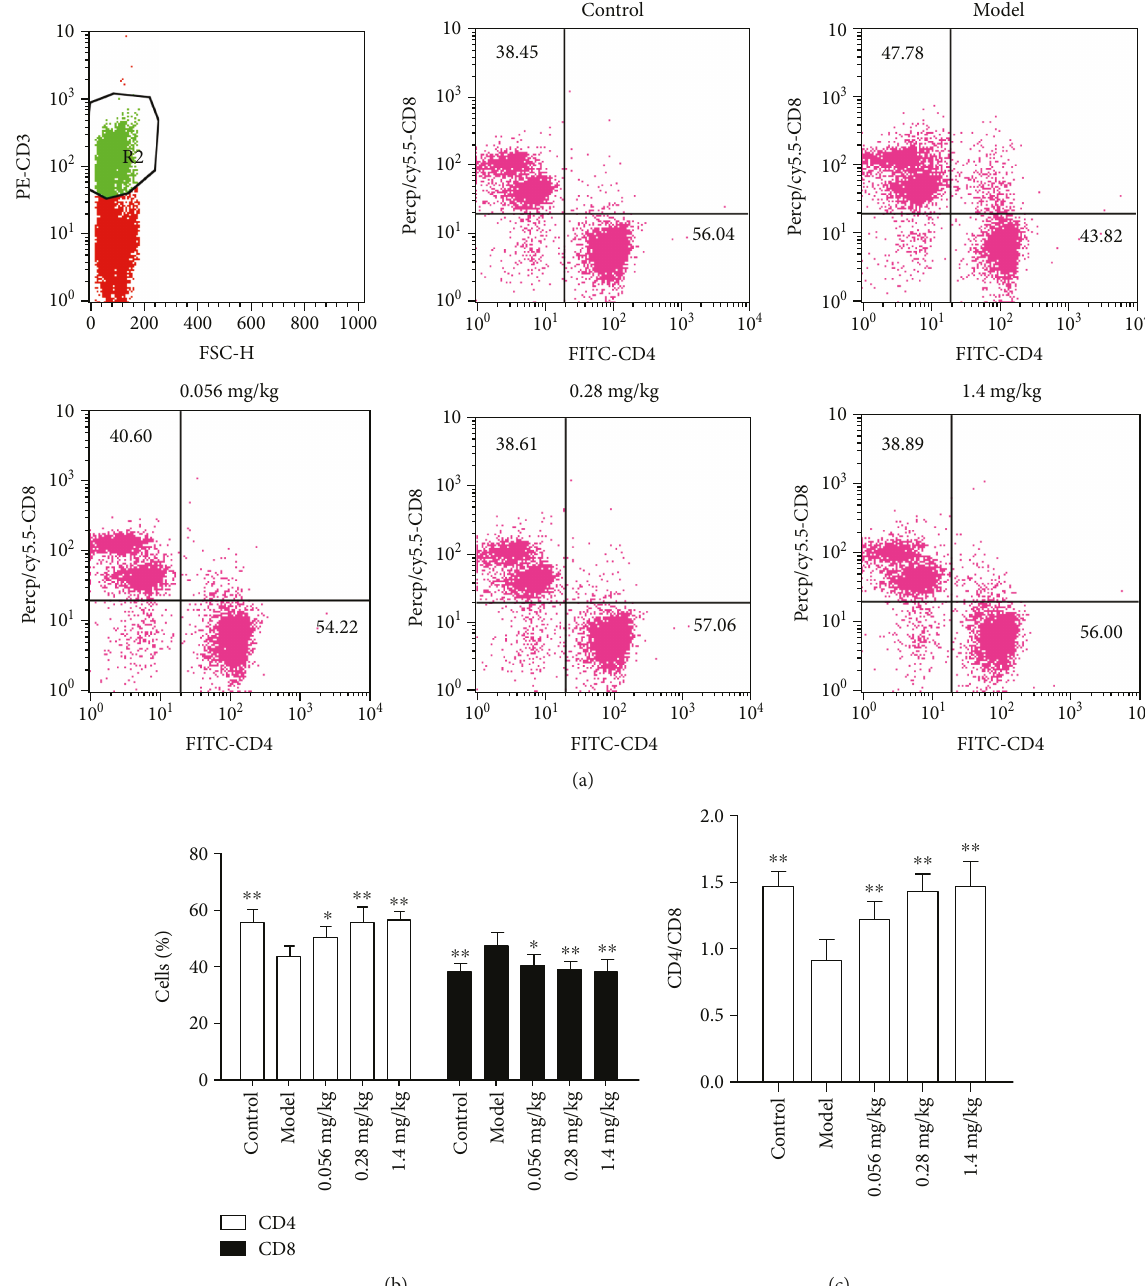
Figure 5: Koumine reduces the number of total leukocytes and CD4 + T cells in fi ltrated in the liver. The livers were isolated from model and koumine-treated rats. (a) Cells were analyzed for expression of CD4, CD8, and CD3 by fl ow cytometry. (b) The percentages of cells that are positive to these antigens were represented. ∗ p < 0 05 and ∗∗ p < 0 01 versus